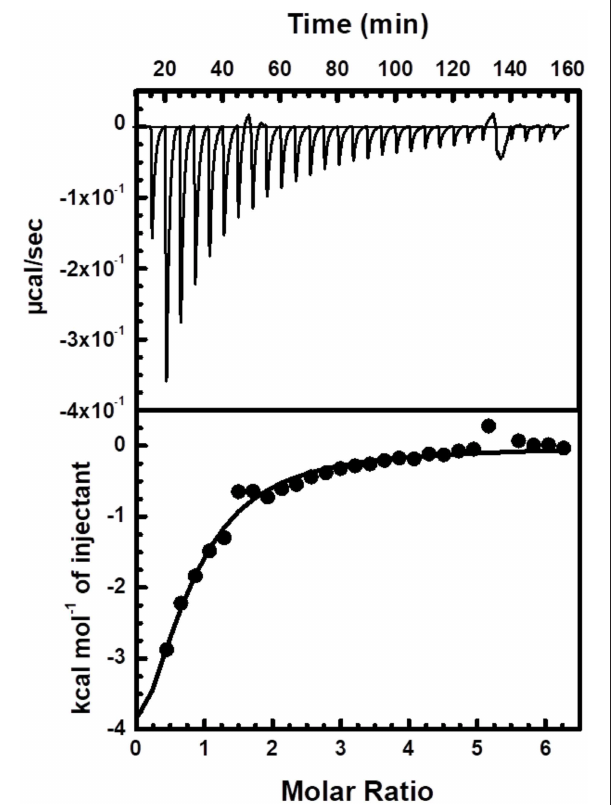
FIGURE 6 | Interaction between Ydj1 and Zn verified by ITC. Thermodynamic parameters were derived from non-linear least-squares fitting implemented by the Origin software. The ITC experiment consisted of 3 µ l injections of 3mM ZnCl 2 to 30 µ M Ydj1 (monomer concentration) with an interval of 300s between injections. Solutions of titrants and titrates were made from the same buffer [25 mmol L − 1 Tris-HCl buffer (pH 7.5) and 500 mmol L − 1 NaCl] and thoroughly degassed prior to use.